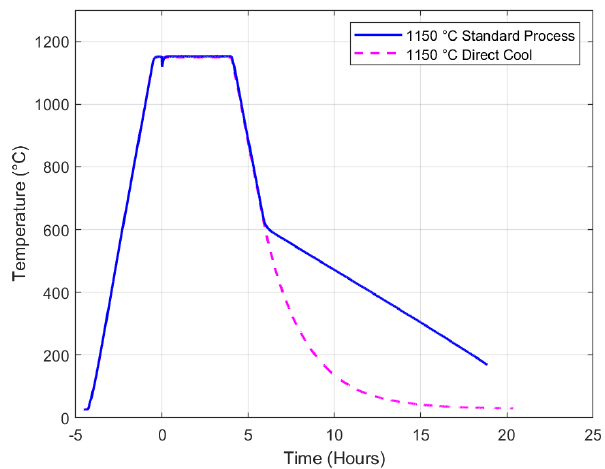
Figure 10. Standard heat treatment with slow post-disordering cool compared to direct cooling.